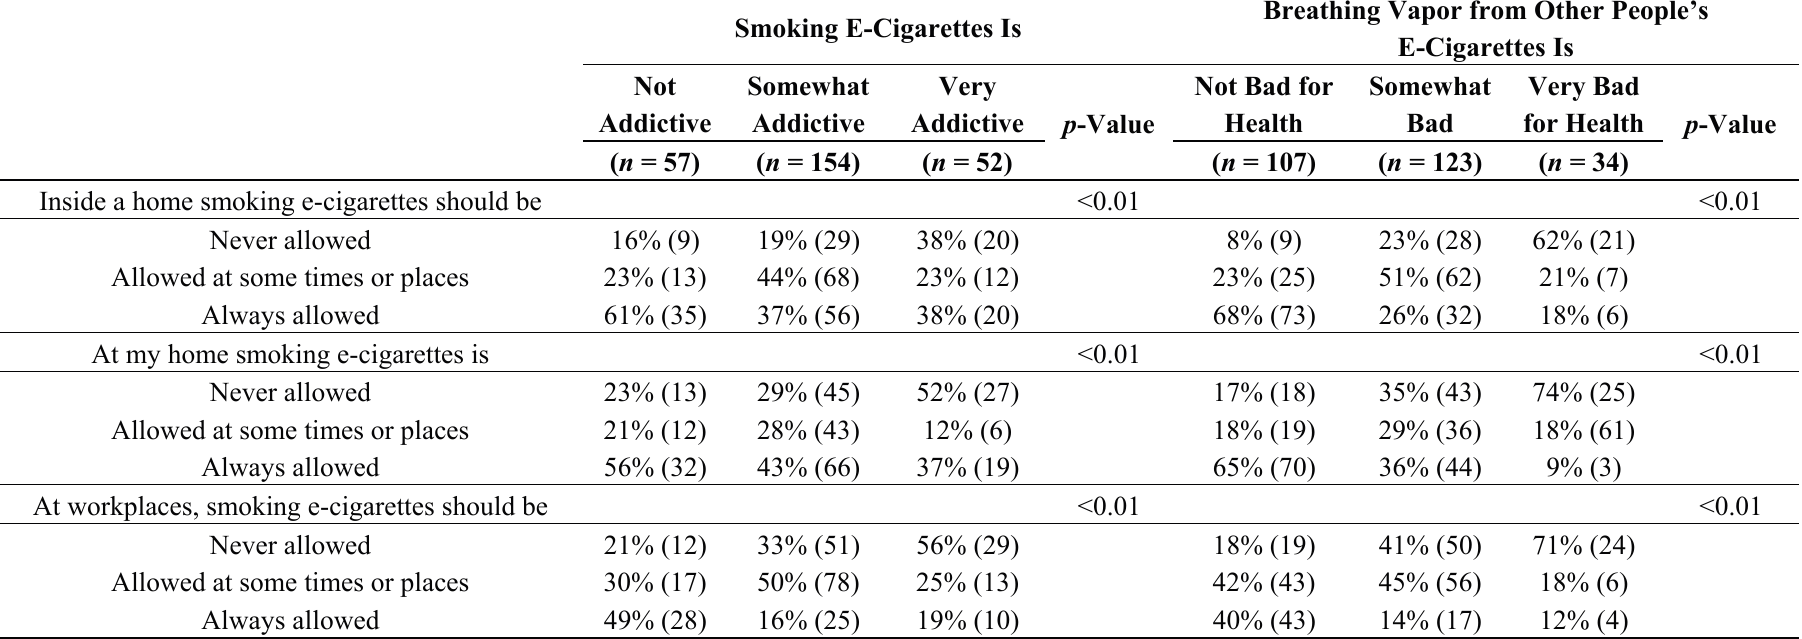
Table 3. Associations between support for indoor e-cigarette bans and risk perceptions.